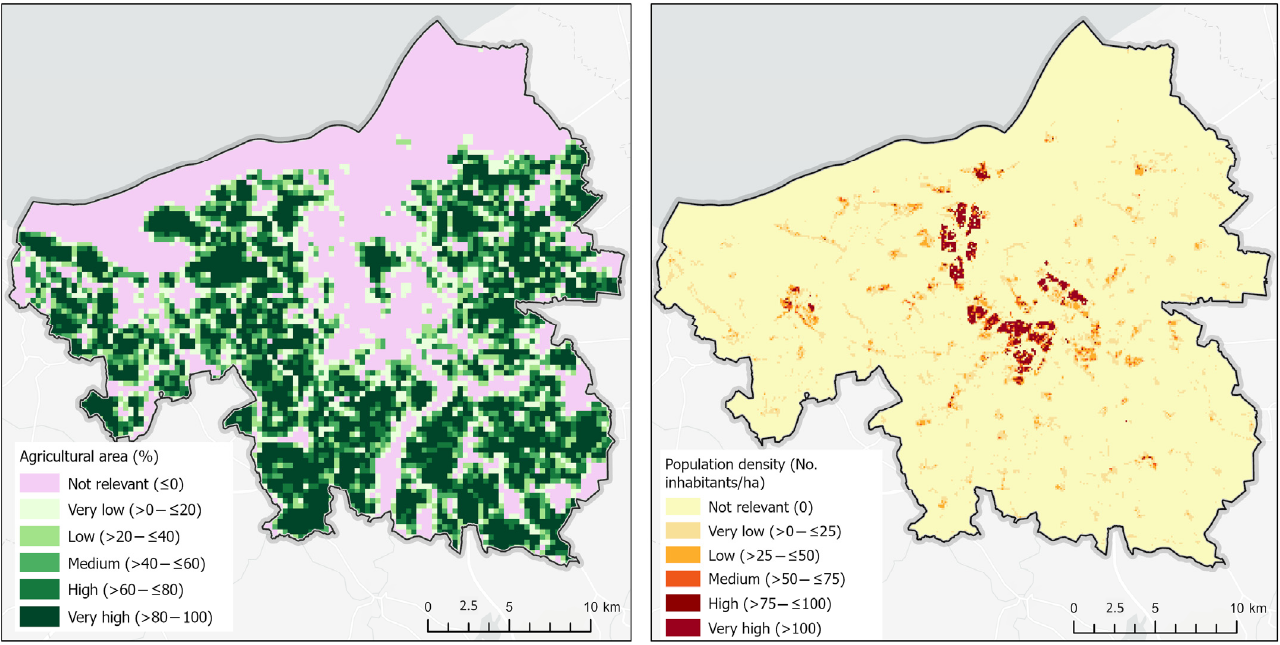
Figure 3. Spatial patterns of ES supply of and demand for food (from cultivated terrestrial plants) in the urban region of Rostock. ES supply and demand have been mapped using the indicators agricultural areas (%) and population density (inhabitants ha − 1 ), respectively.